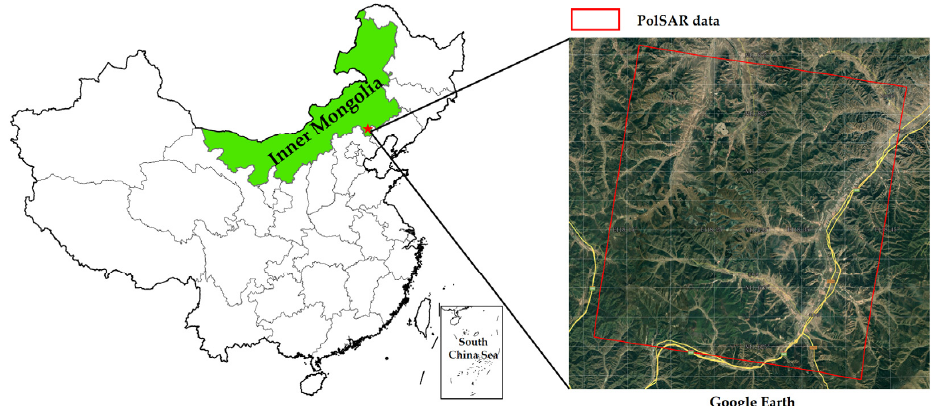
Figure 1. Location of the test site and data coverage of PolSAR data.